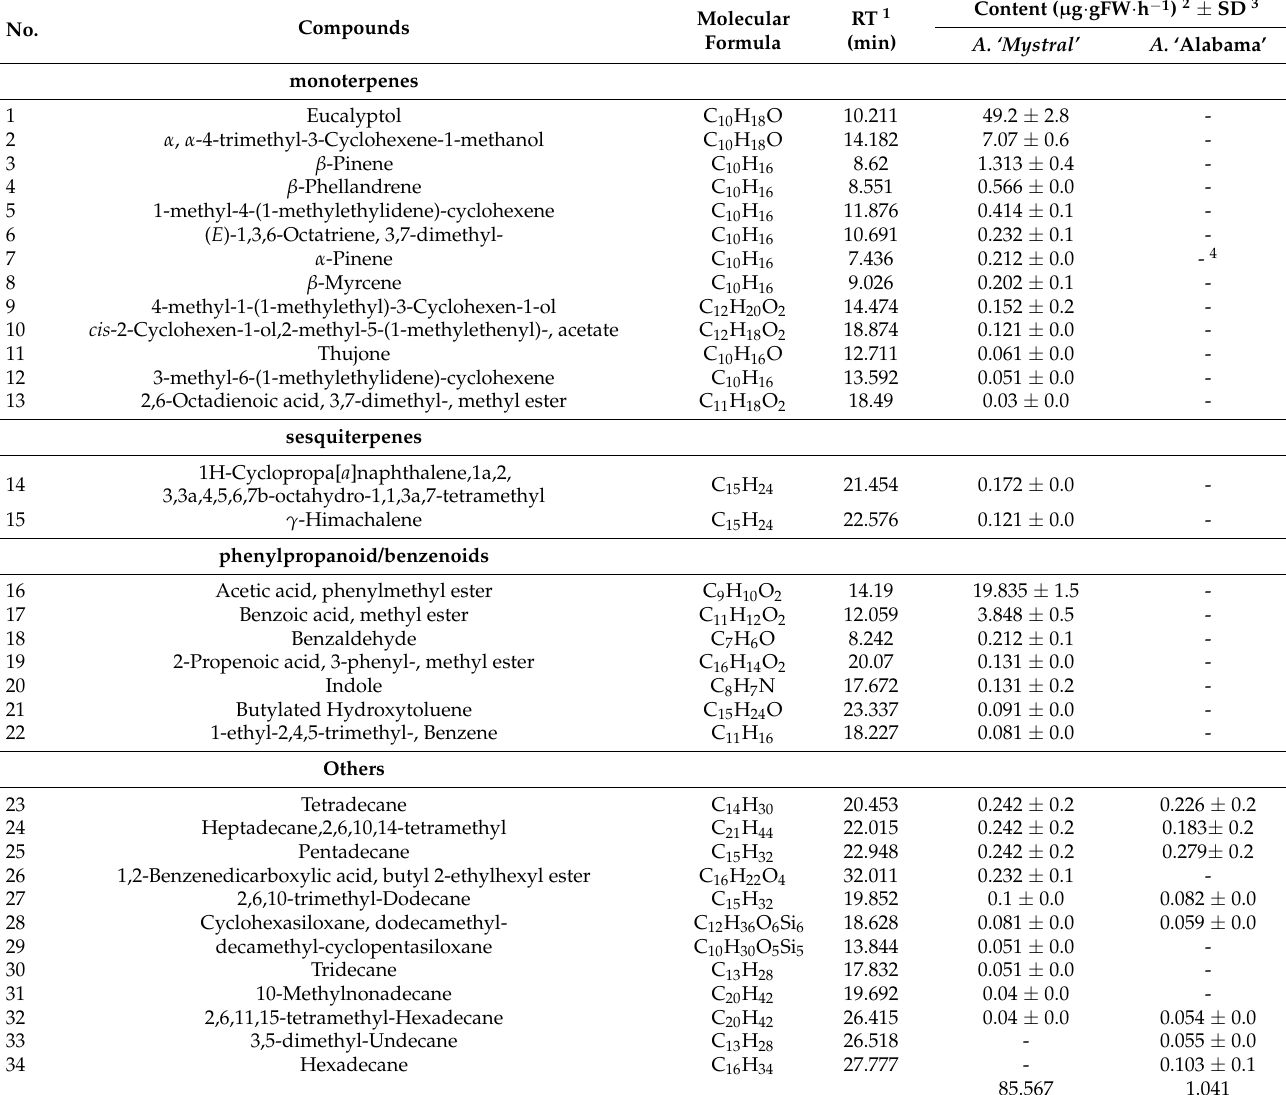
Table 1. Relative amounts of volatile compounds identified in A. ‘Mystral’ and A.